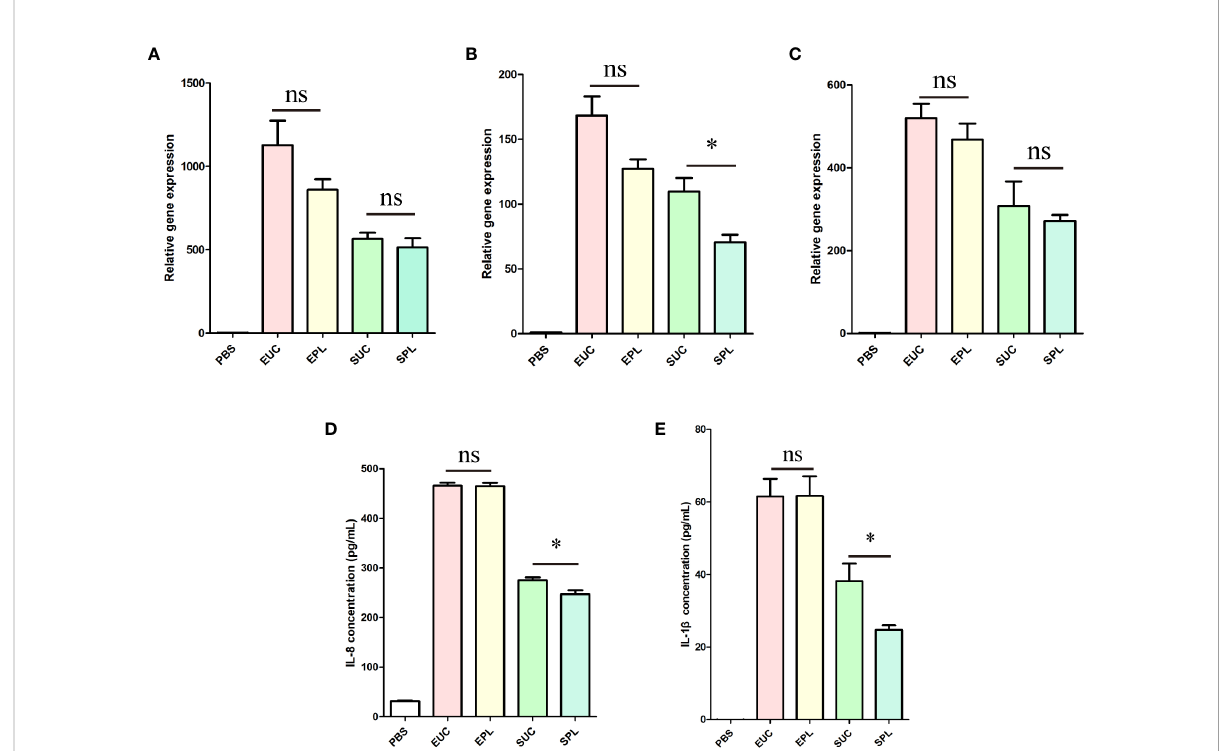
FIGURE 7 The expression of cytokines by THP-1 cells upon stimulation with BEVs. EUC, 1 m g/mL E. coli BEV isolated by UC; EPL, 1 m g/mL E. coli BEV isolated by PL; SUC, 10 m g/mL S. aureus BEV isolated by UC; SPL, 10 m g/mL S. aureus BEV isolated by PL. (A) The gene expression of IL-1 b . (B) The gene expression of IL-6. (C) The gene expression of IL-8. (D) The release of IL-8. (E) The release of IL-1 b . n = 3 biological replicates, ± s.e.m. Signi fi cant differences compared to the PBS groups are indicated by asterisks: *p < 0.05; ns represents no signi fi